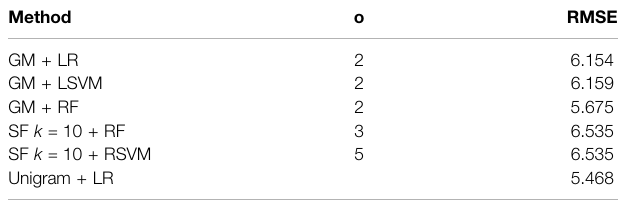
TABLE5| MMSEofthebestperformingembedding/regressioncombinationfrom the training set on the test set. We choose the three best performing graph measureapproaches,thetwobestSFapproachesandthebestunigrammethod.